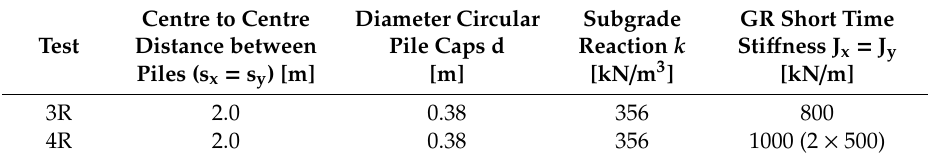
Table 2. Parameters of the French